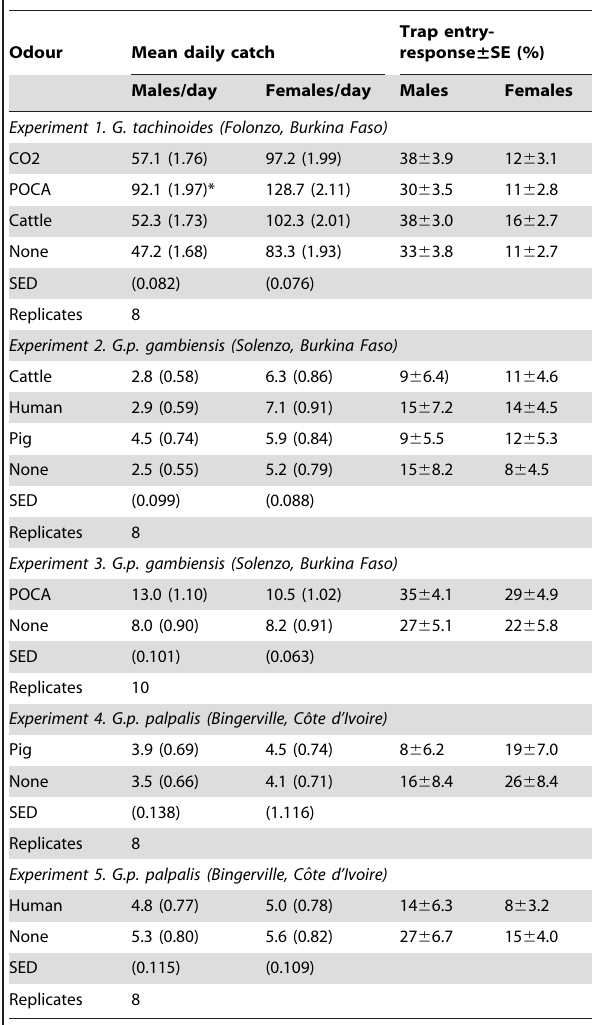
Catches accompanied by * differ from the unbaited control trap at the 0.05 level of probability. Catches of the unbaited devices are accompanied by their respective transformed means 6 SED shown in brackets. (Table 2). Similarly, carbon dioxide dispensed at 1 L/min or 2 L/ min increased the catch by up to 1.8 6 and 4.6 6 , respectively.